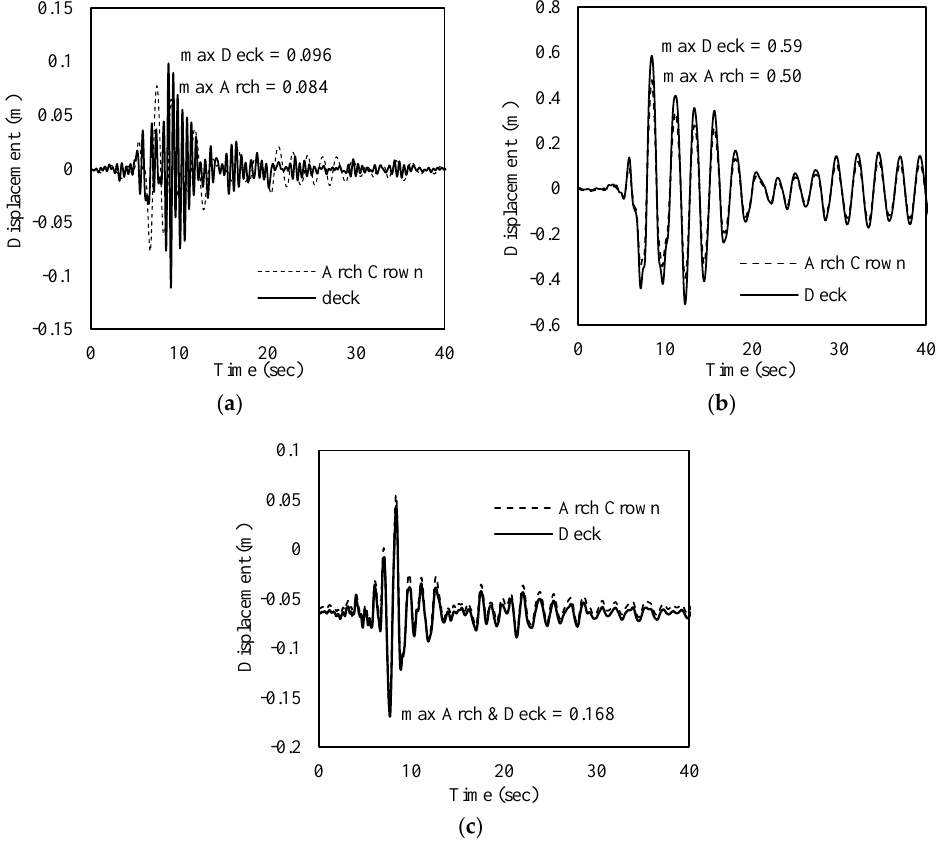
Figure 11. Deck and arch crown displacement histories for Imperial Valley-06 earthquake. ( a ) Longitudinal direction; ( b ) Transverse direction; ( c ) Vertical direction.